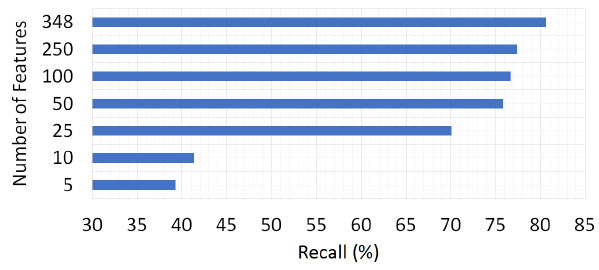
Figure 9. The effect of the number of features on the classification